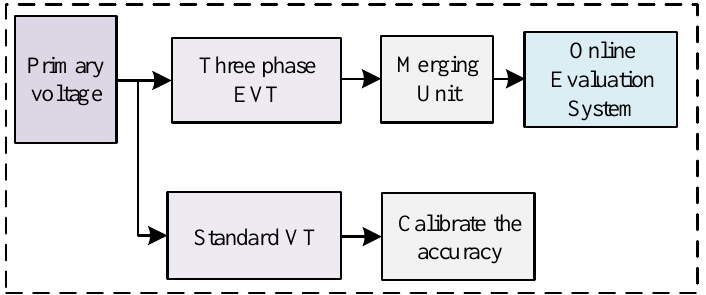
Figure 1. Schematic diagram of the field test. EVT: electronic voltage transformer. VT: voltage Figure1. Schematicdiagramofthefieldtest. EVT:electronicvoltagetransformer. VT:voltagetransformer transformer In the proposed evaluation method, the output of the EVT is fed into a merging unit. The ratio error of the EVT is calculated using a standard transformer operating in parallel with the EVT, as shown in Figure 1. The process of the proposed online evaluation of the EVT is divided into o ffl ine learning using PCA and online learning through RPCA, as shown in Figure 2. The initial principal component model is established by PCA, and then the model is recursively updated by RPCA. The tasks of the two developed models are briefly elaborated below: O ffl ine learning by